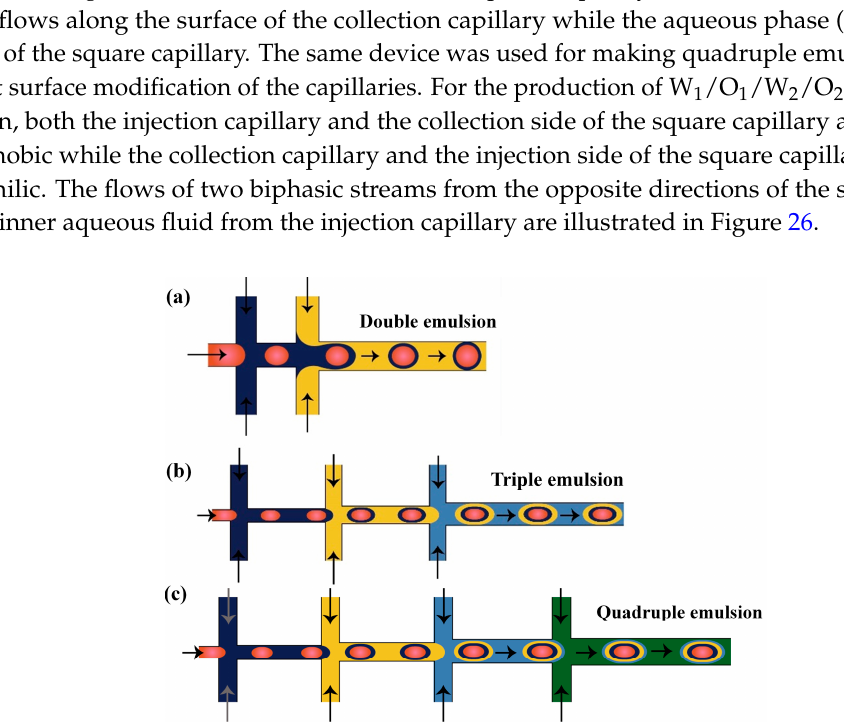
Figure 22. A tapered array of seven glass capillaries inserted into a collection capillary. The three distinct inner aqueous phases were delivered through nonadjacent peripheral capillaries [145].